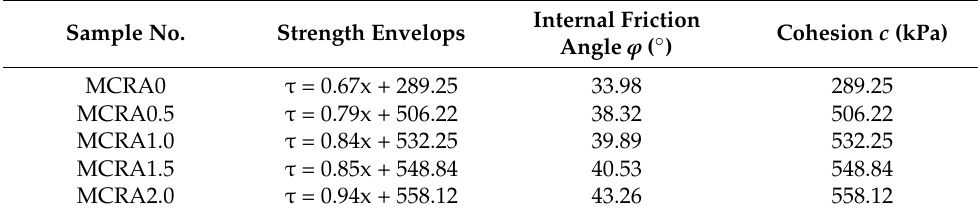
Table 6. Shear strength parameters of